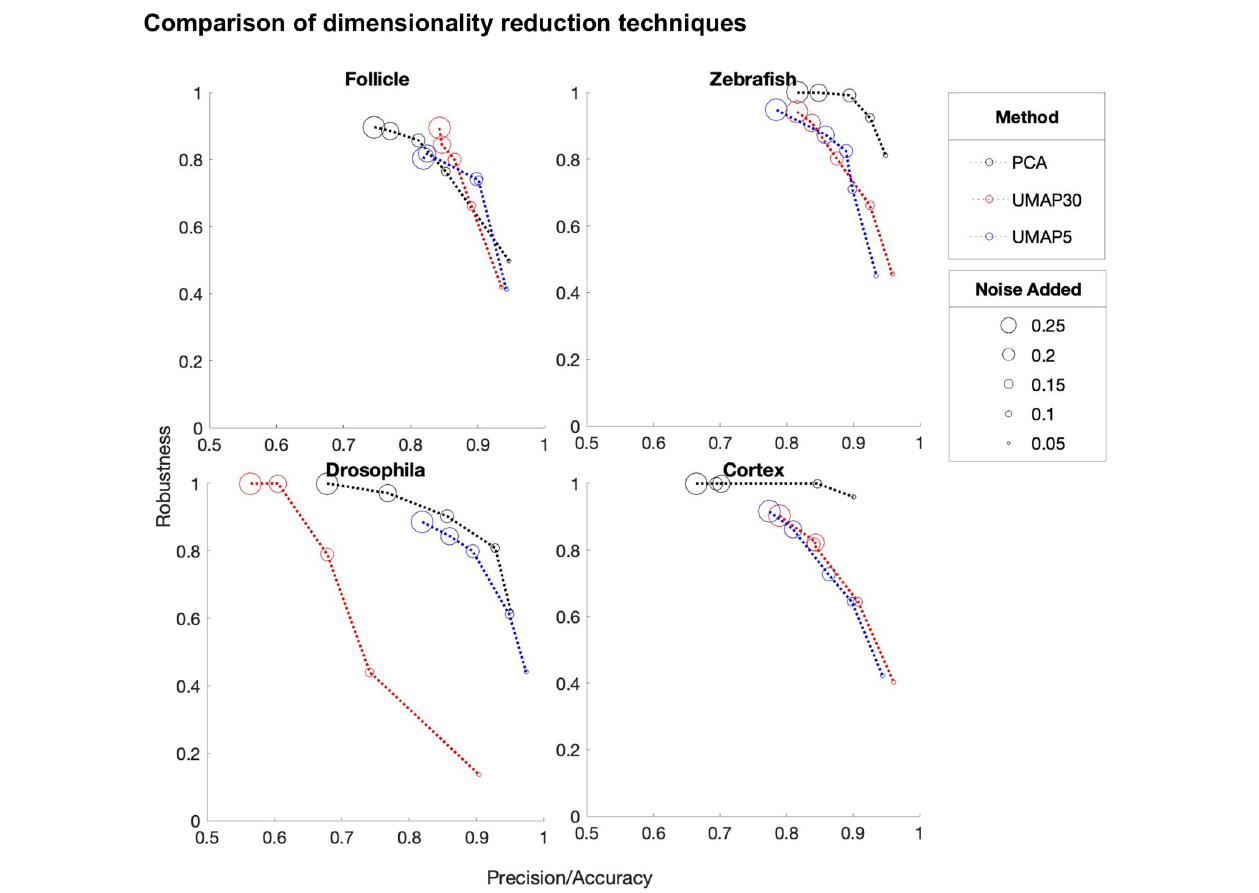
FIGURE 8 | A comparison of the performance of DEEPsc networks using different dimensionality reduction methods on each of the biological systems for various levels of added noise during training. We compare principal component analysis (PCA) to Uniform Manifold Approximation and Projection (UMAP) with n_neighbors = 30 (UMAP30) and n_neighbors = 5 (UMAP5). Each of these methods reduce the dimensionality of the initial dataset to n_dimensions = 8 . These scores are each defined to be one minus the corresponding penalty term in the performance score, so that a higher score is better. Since most methods have